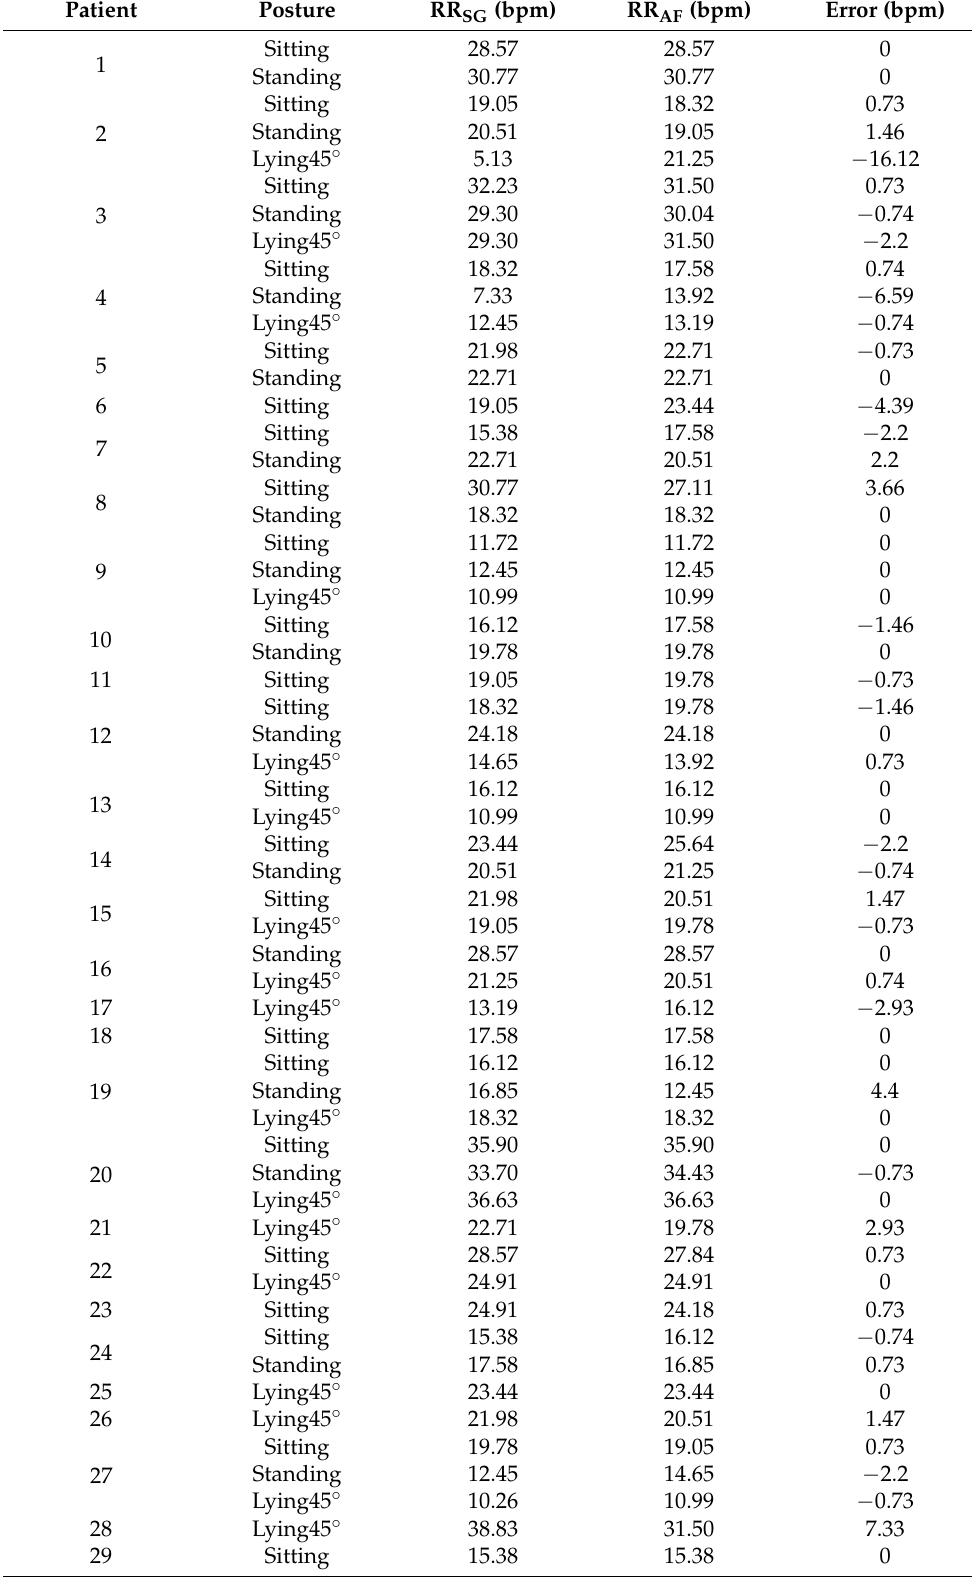
Table A3. RR AF and RR SG of the COPD measured in addition to the relative error at different body